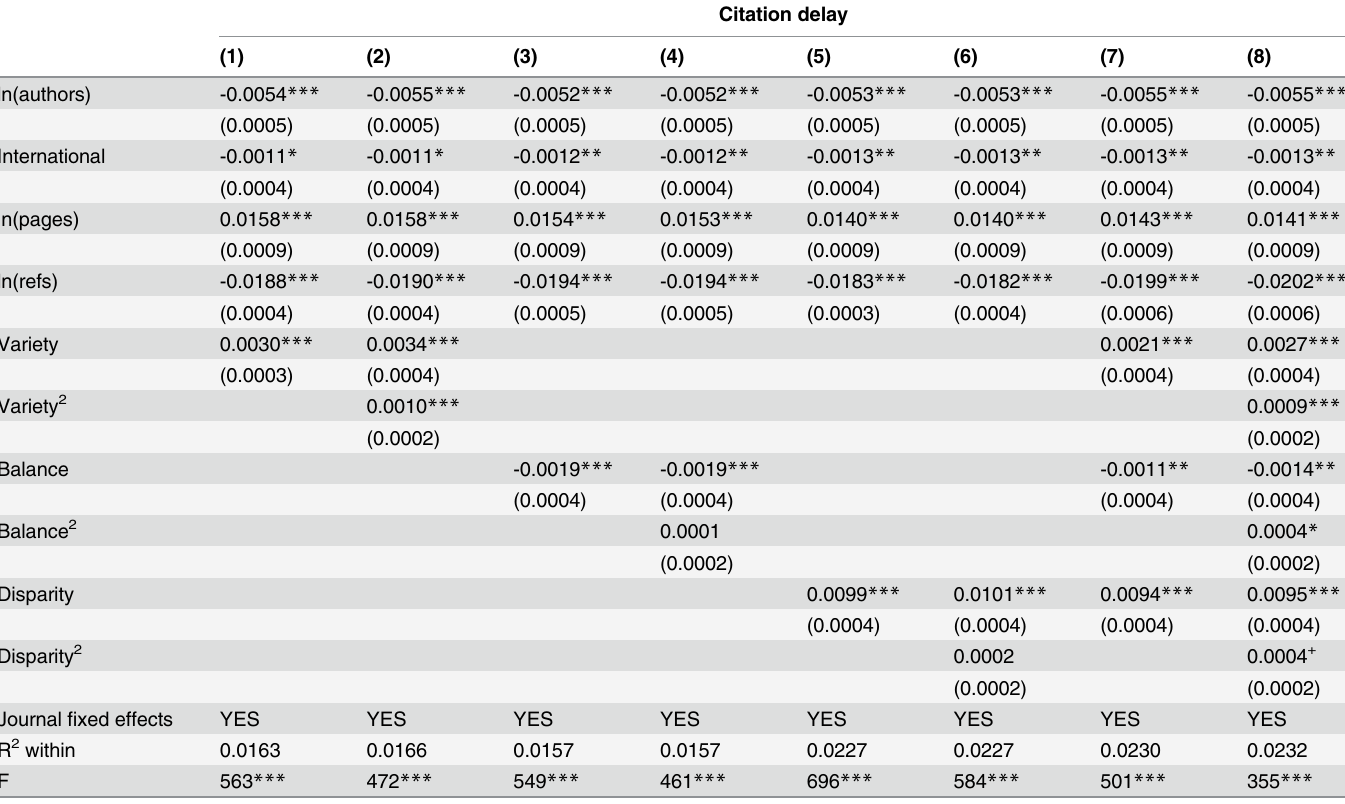
Table 7. Fixed Effects Least Squares Models: Interdisciplinarity and Citation Delay ( N =